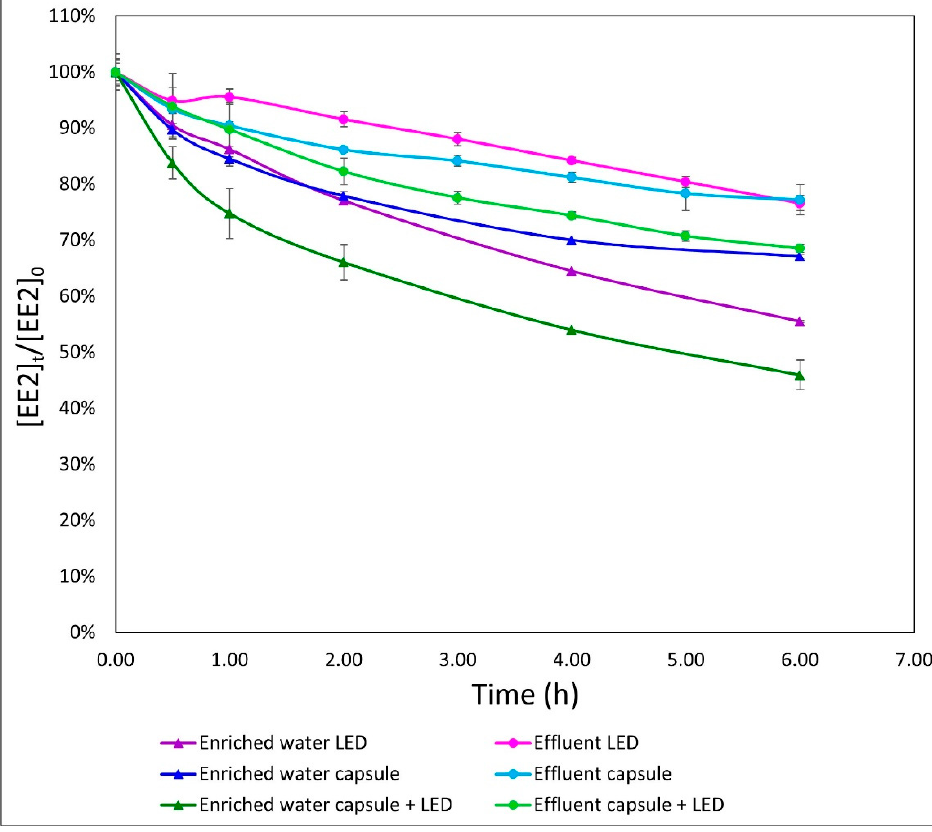
Figure 5. Comparison of two different media: enriched water and effluent wastewater, and three different processes: UV-LED (wavelengths 267.7 nm and 277.4 nm), SBP capsule (encapsulating R. zopfii culture) and both together, in a volume of 3 L with EE2 (0.5 mg/L) versus time.